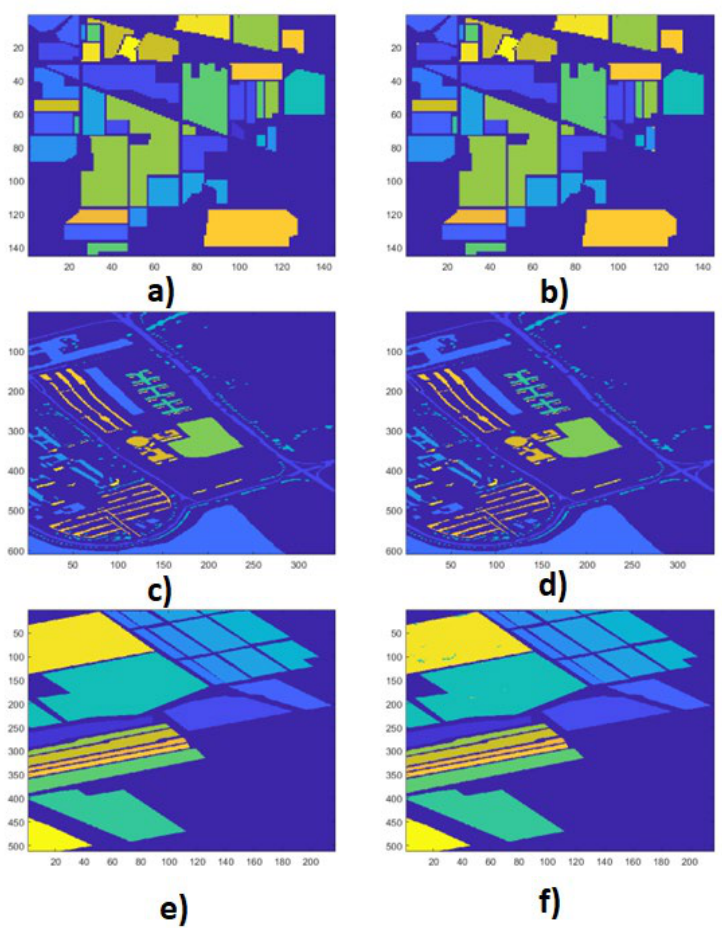
Figure. 2 . Ground truth data and results of the MLP-Mixer; a) Indian Pines reference data, b) Classified Indian Pines HIS data c) Pavia